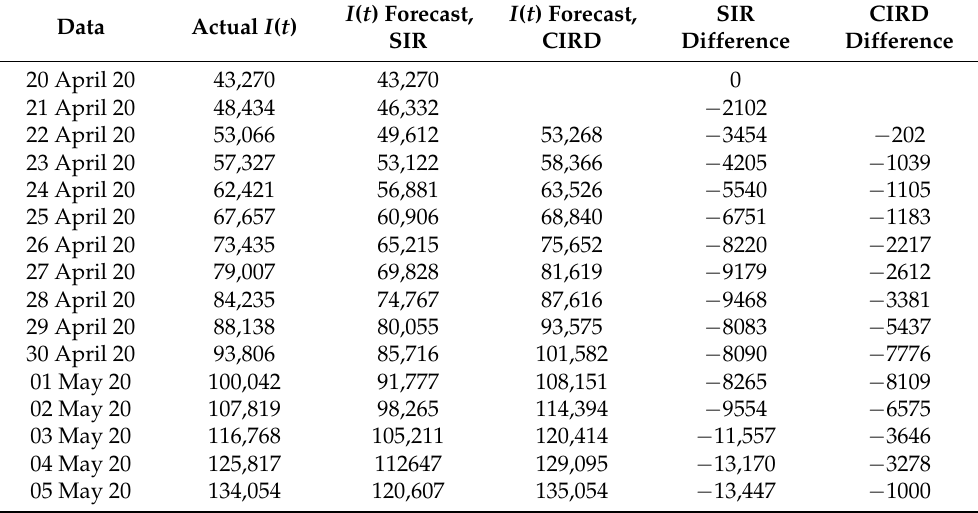
Table 3. The I ( t ) forecast results for the SIR and CIRD models, for the period from 20 April 2020